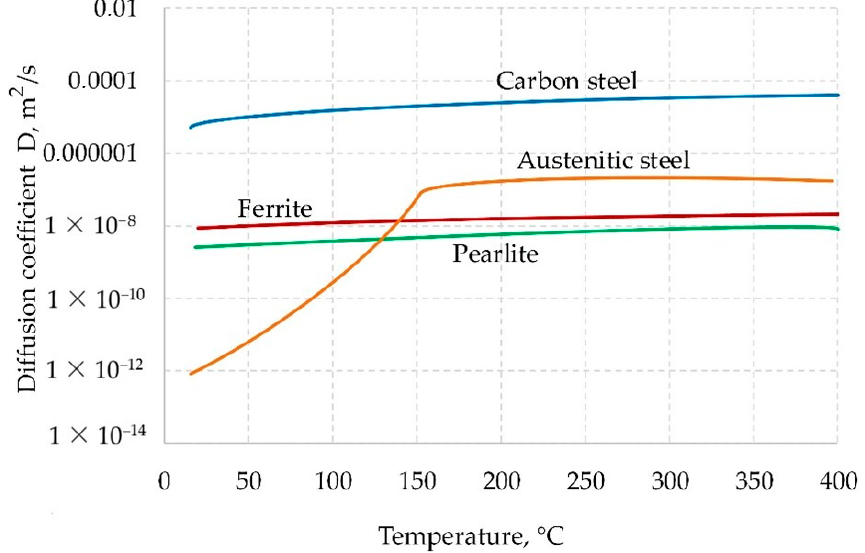
Figure 7. Dependence of the critical strain rate for impurity carbon ( С ), nitrogen (N), hydrogen (H) and oxygen (O) atoms on temperature at a dislocation density d